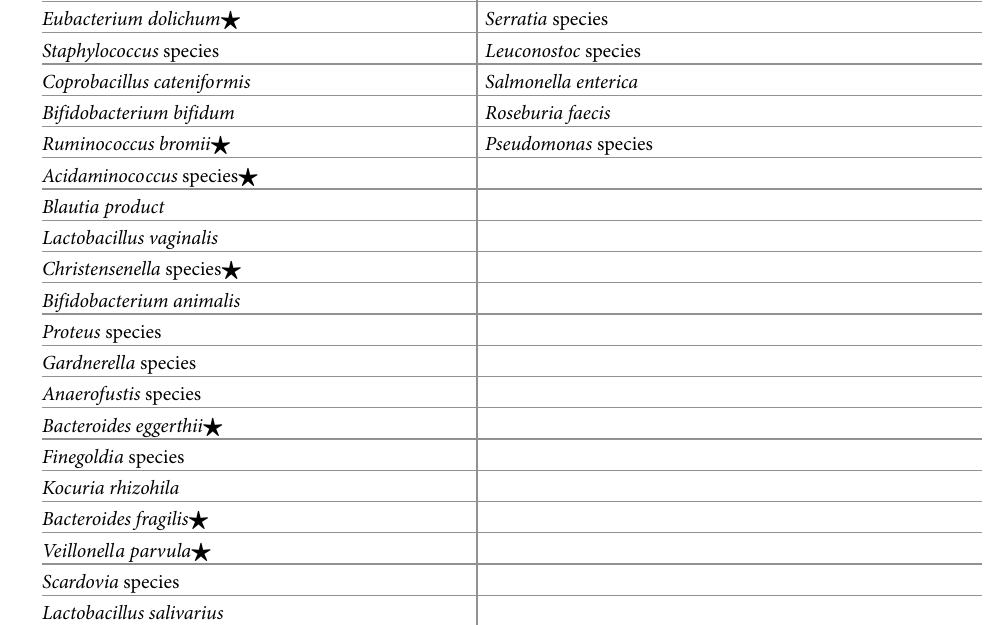
Table 2. Abundant bacterial species in RP patients and normal individuals. Abundant species in RP